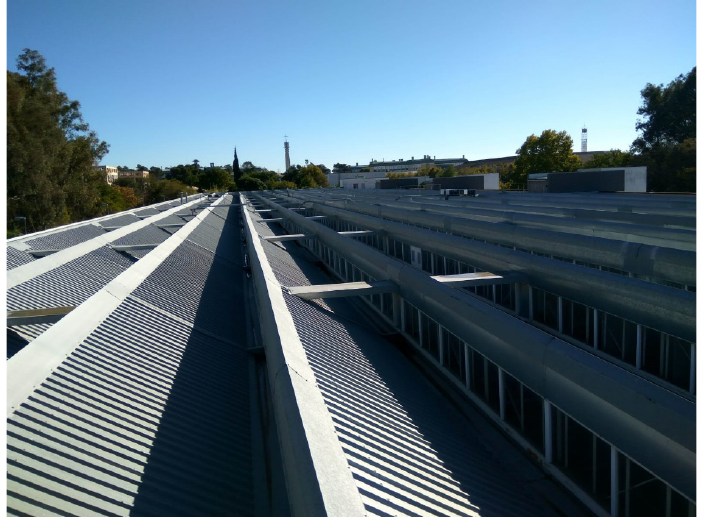
Figure 2. Photograph of the roof of the Leonardo da Vinci building of the Rabanales University Campus of the University of Córdoba (Spain).